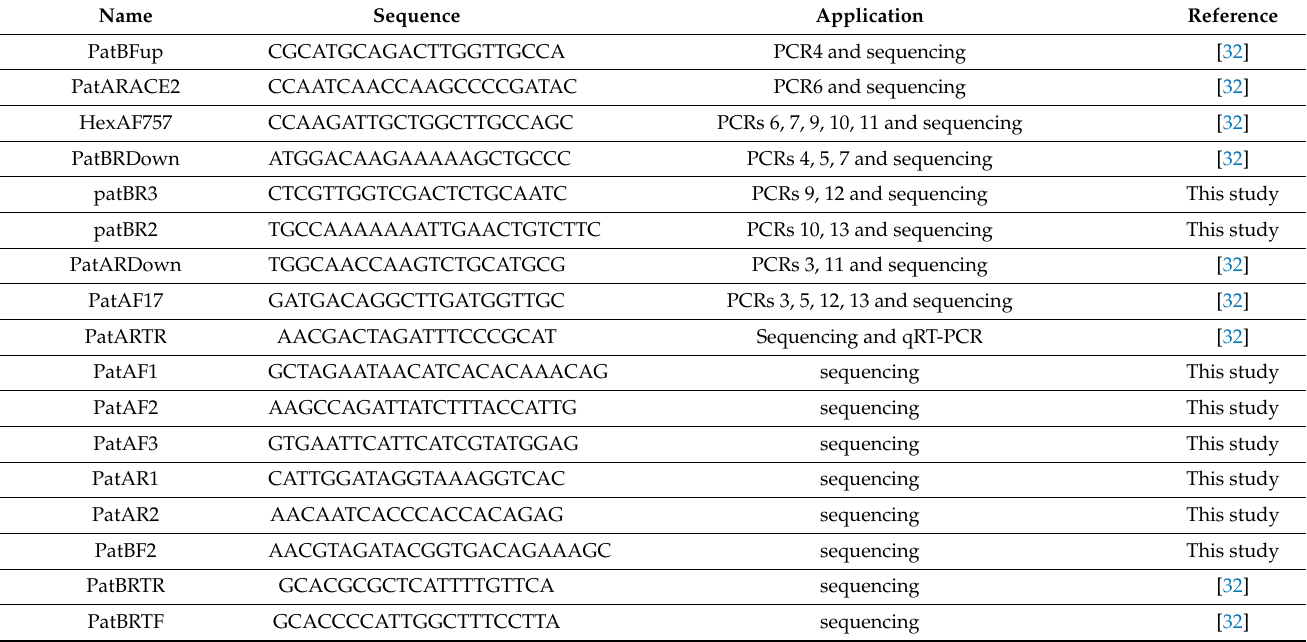
Table 2. Oligonucleotides used in this